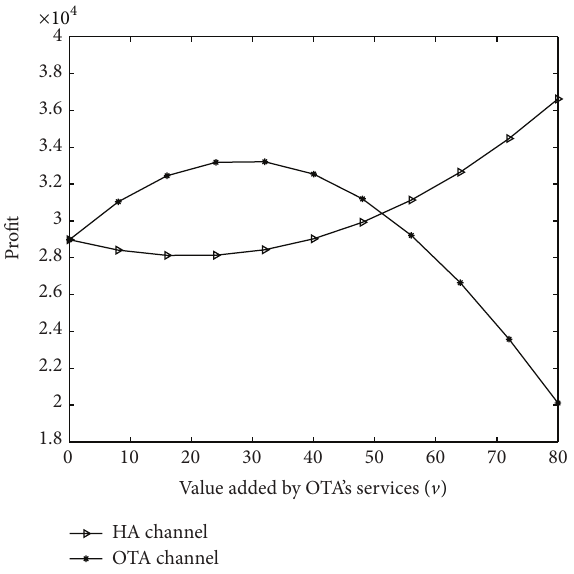
Figure 6: Channel profits in the integrated system.